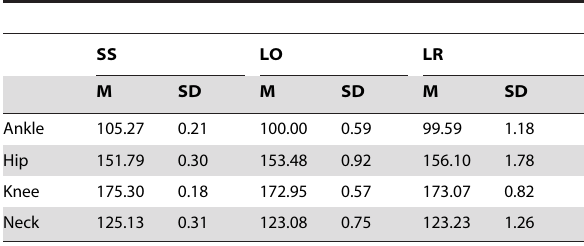
Table 1. Mean (M) and standard deviation (SD) of the joint angle ( u ) as a function of postural task.